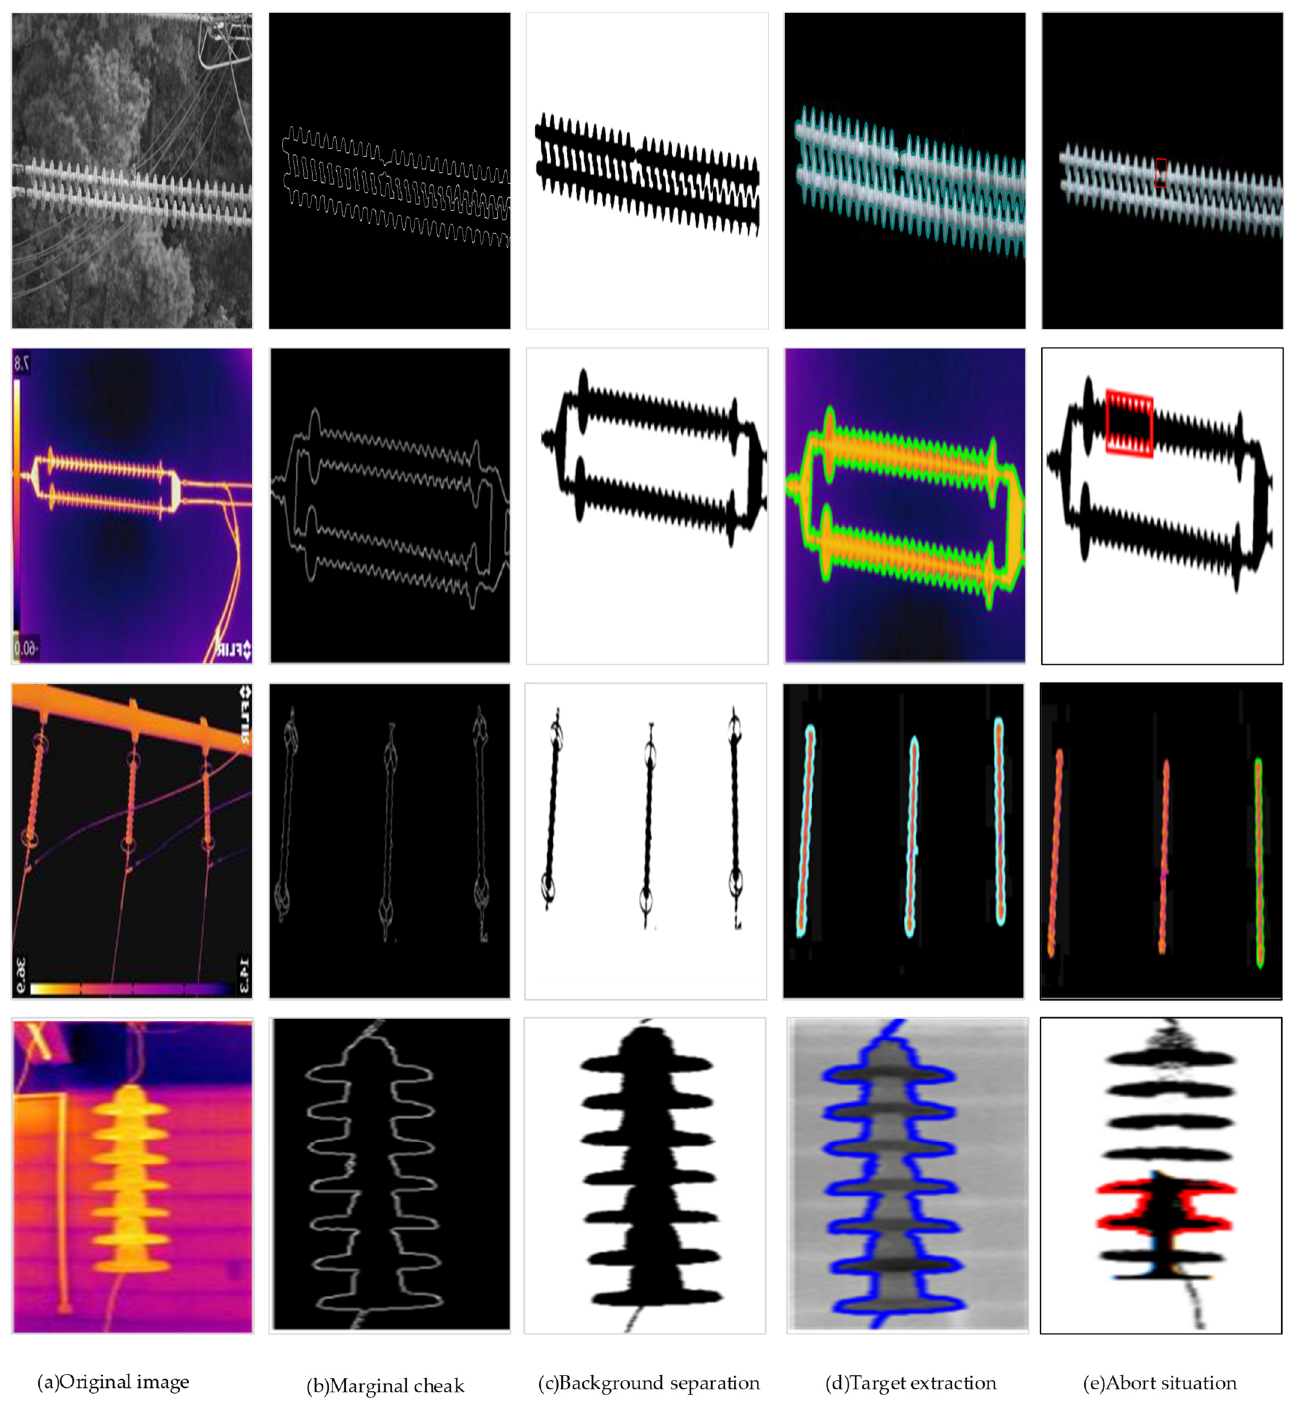
Figure 9. Visualization of the image processing process.